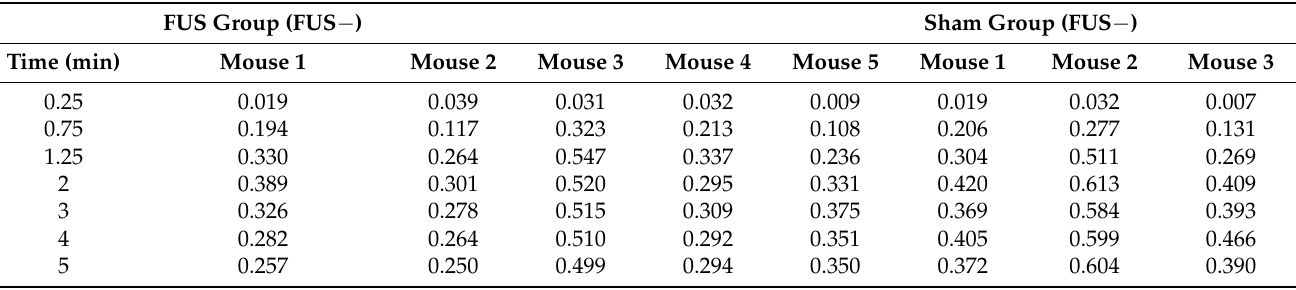
Table A2. SUV values—left